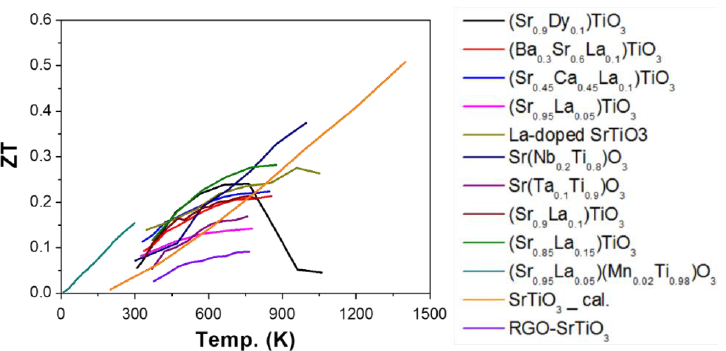
Figure 5. ZT value of ATiO 3 based oxide perovskite materials, all the materials are n-type semiconductors. The symbol “cal.” means the results come from the calculation.